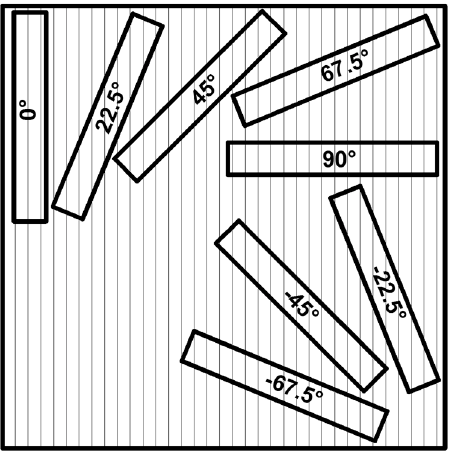
Figure 4. Scheme of cutting specimens from 7-ply A-type boards. Numbers designate the first layer tissue orientation according to the individual specimen coordinate system ( x , y , z ).